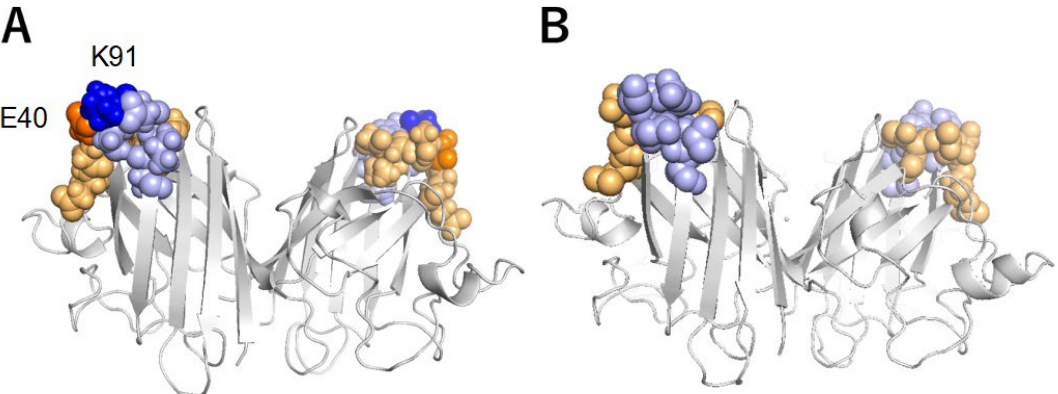
Figure 6. "β -barrel plug" in canine ( A ) and human ( B ) SOD1 structures. The residues 37–42 and 90–95 comprising the β -barrel plug are colored light orange and blue in the SOD1 structures, respectively. E40 and K91 are colored in bright orange and blue in cSOD1, respectively.